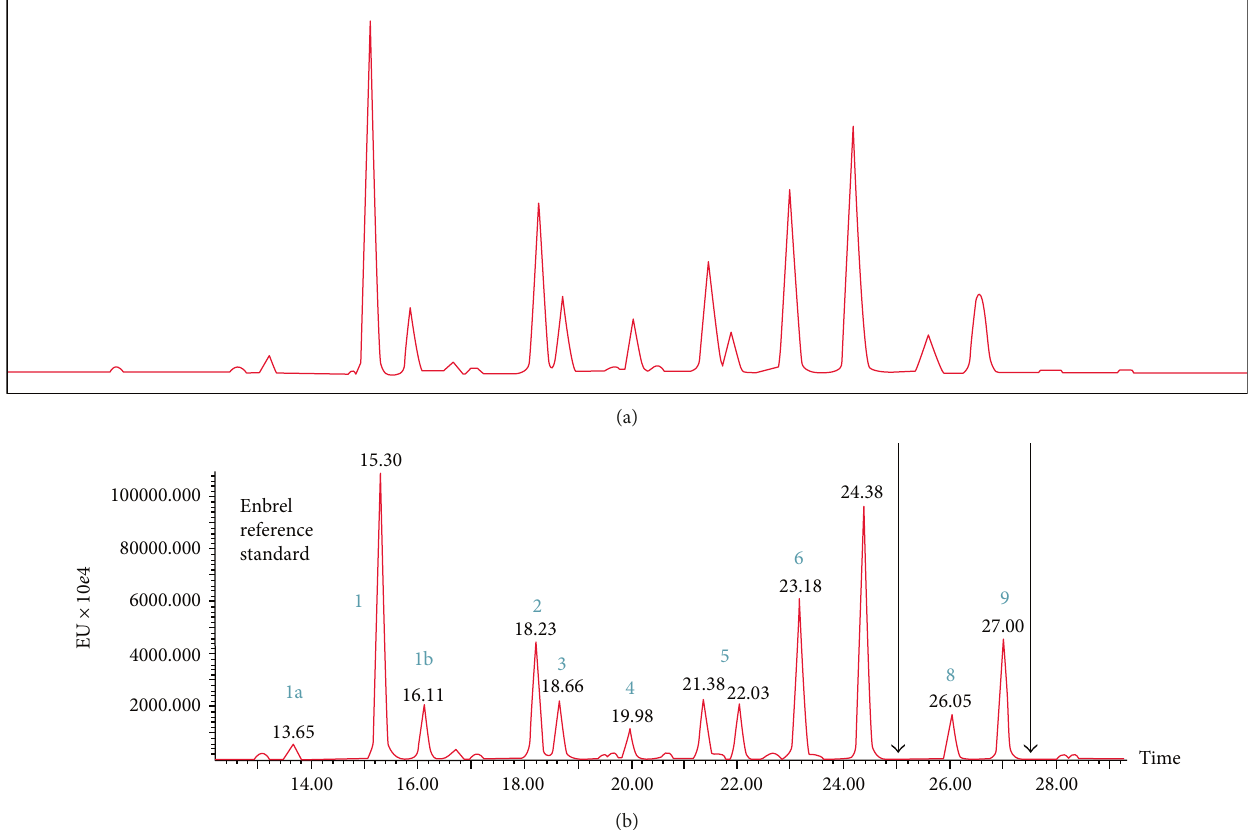
Figure 1: (a) Questioned Enbrel chromatogram included in Figure 3 panel b of Miranda-Hernández et al. [2] in comparison to (b) P fi zer ’ s analysis by UPLC of Enbrel reference standard included in the Letter to the Editor 5047067